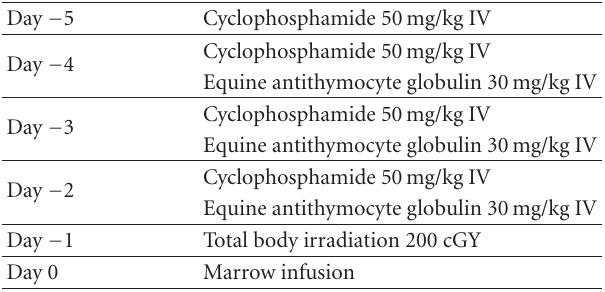
Table 1: Cyclophosphamide/TBI/eATG